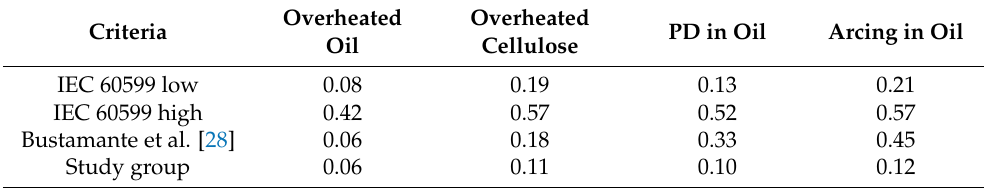
Table 6. The calculated increases in health index score for faults determined by the Key Gas Method for 90th percentile gas increases.